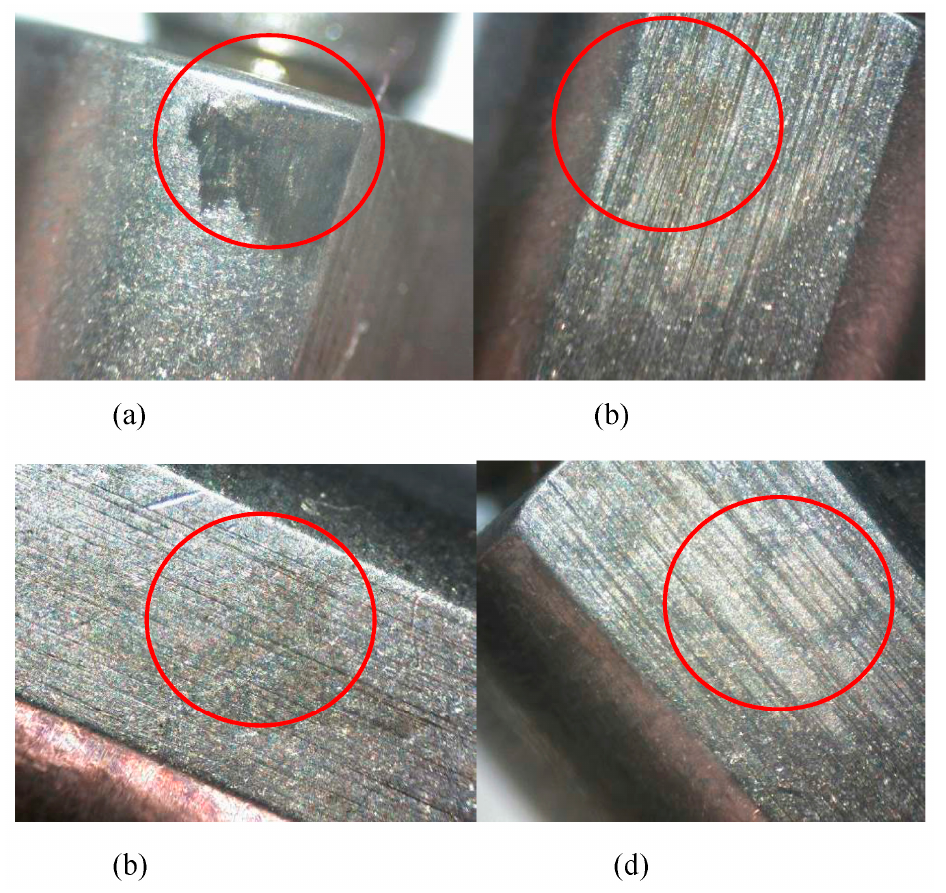
Figure 12. Magnified view (10×) of the injector plungers.